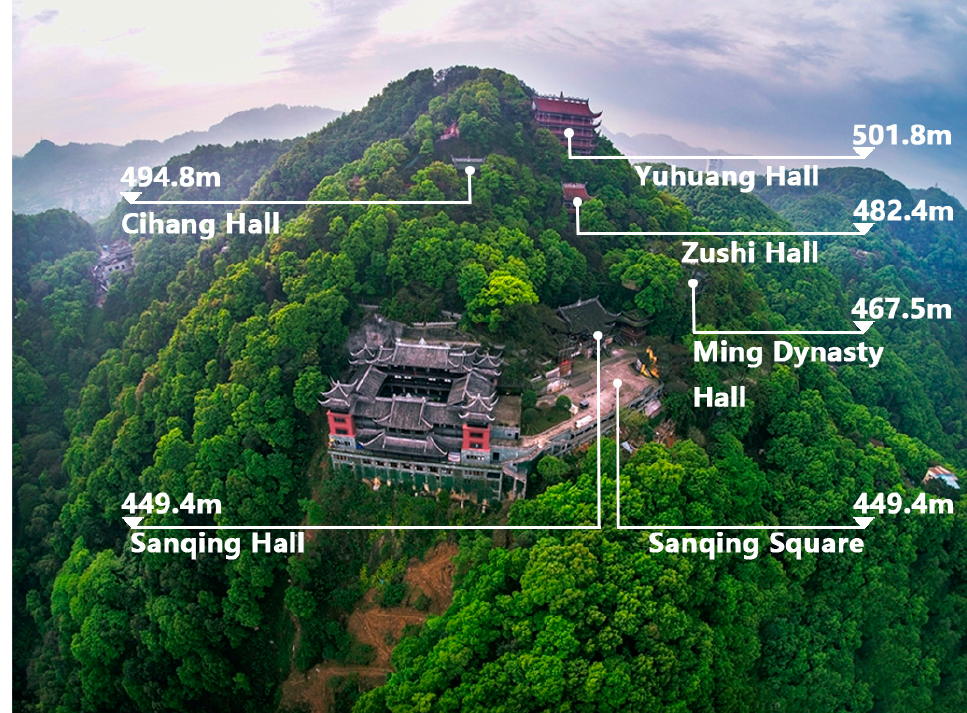
Figure 2. Spatial distribution and elevations of the main attractions of Laojundong Temple.